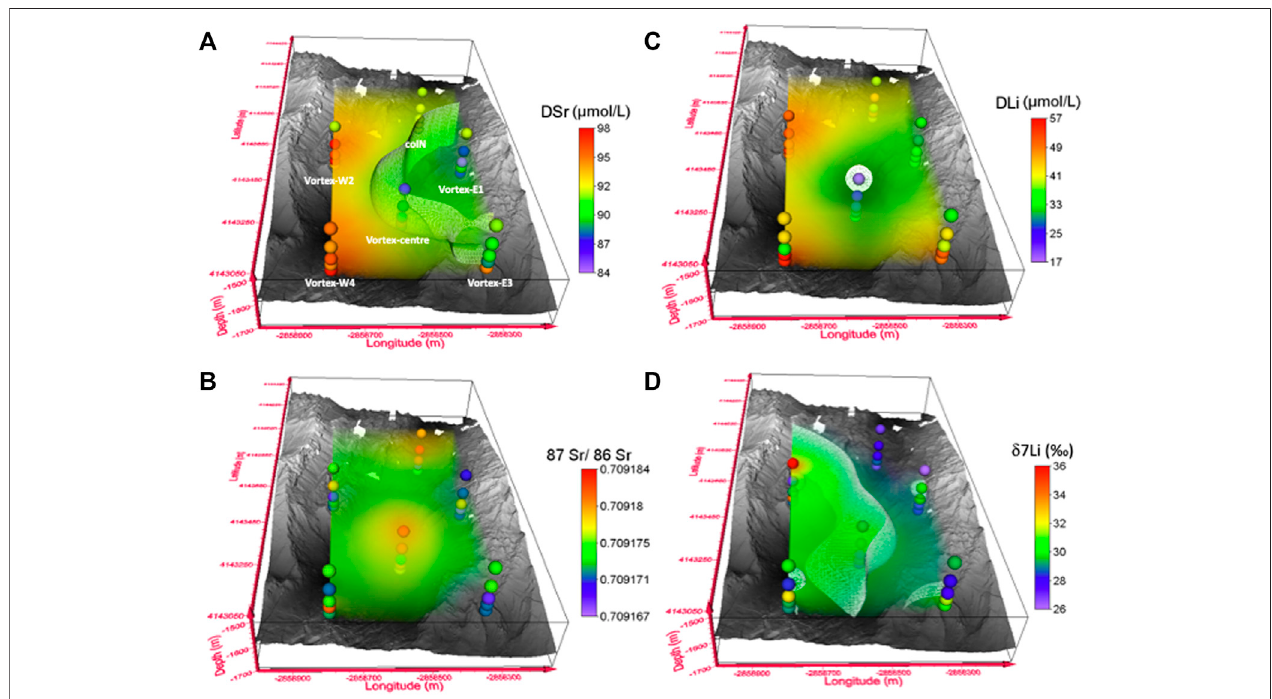
FIGURE 3 | Dissolved Sr and Li concentrations [ (A) and (C) , respectively] and isotopic compositions [ (B) and (D) , respectively] are presented as a 3D scatter plot over the LSHF bathymetric map. The dispersion of the data points is simulated with volume rendering. The isosurfaces are fi xed at the seawater composition, i.e., (A) 91 µmol/L for DSr (Millero et al., 2008), (C) 24.6 µmol/L for DLi (Leleu, 2017), and (D) 29.5 ‰ for δ 7 Li (this